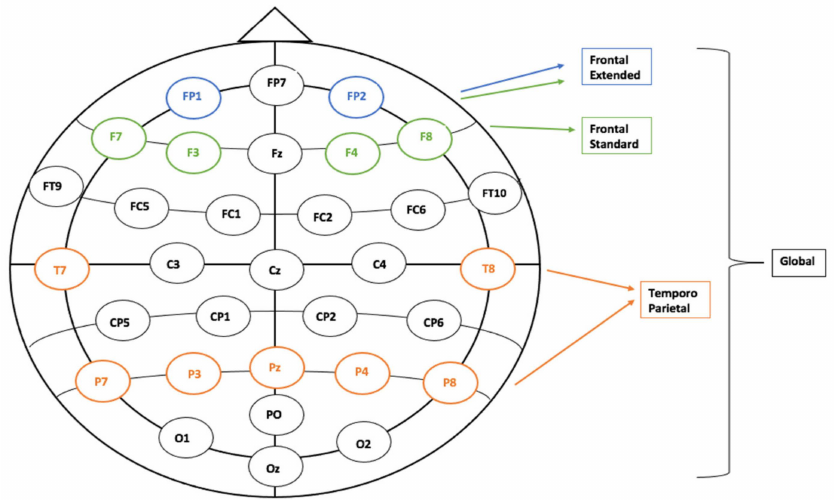
Figure 1. The four Regions of Interest (ROIs)—General—All 32 electrodes; Frontal Standard—4 electrodes; Frontal Extended—6 electrodes; Temporo-Parietal—7 electrodes. The following EEG sequence was recorded and selected for our analysis (1) Eyes open (EO1) for 5 min; (2) Eyes closed (EC1) for 5 min, (3) Cognitive tasks (COG1—RTI; COG2—OTS; COG3—PAL) for 10 min altogether (4) Eyes open (EO2) for 5 min and (5) Eyes closed (EC2) for 5